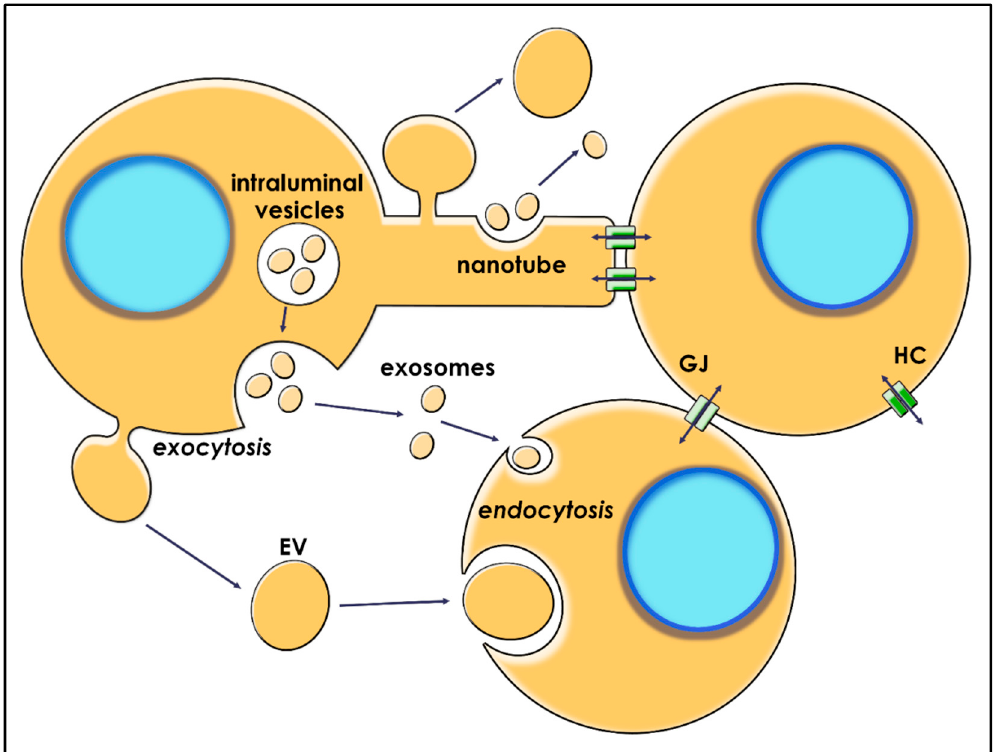
Figure 2. The mechanisms of intercellular communication via miRNA. miRNA can be released as Ago2-bound miRNA or packaged in membrane structures (exosomes and extracellular vesicles). Exosomes and extracellular vesicles (EVs) are englobed by recipient cells through endocytosis or pinocytosis, and miRNAs exert their effects at this level. Cell-cell contact can be mediated by gap junctions (GJs) which directly transfer miRNA between adjacent cells. A similar mechanism is realized by nanotubes which permit direct contact at a distance. Connexins from GJs may also form hemichannels (HCs) and ensure communication with the extracellular environment.